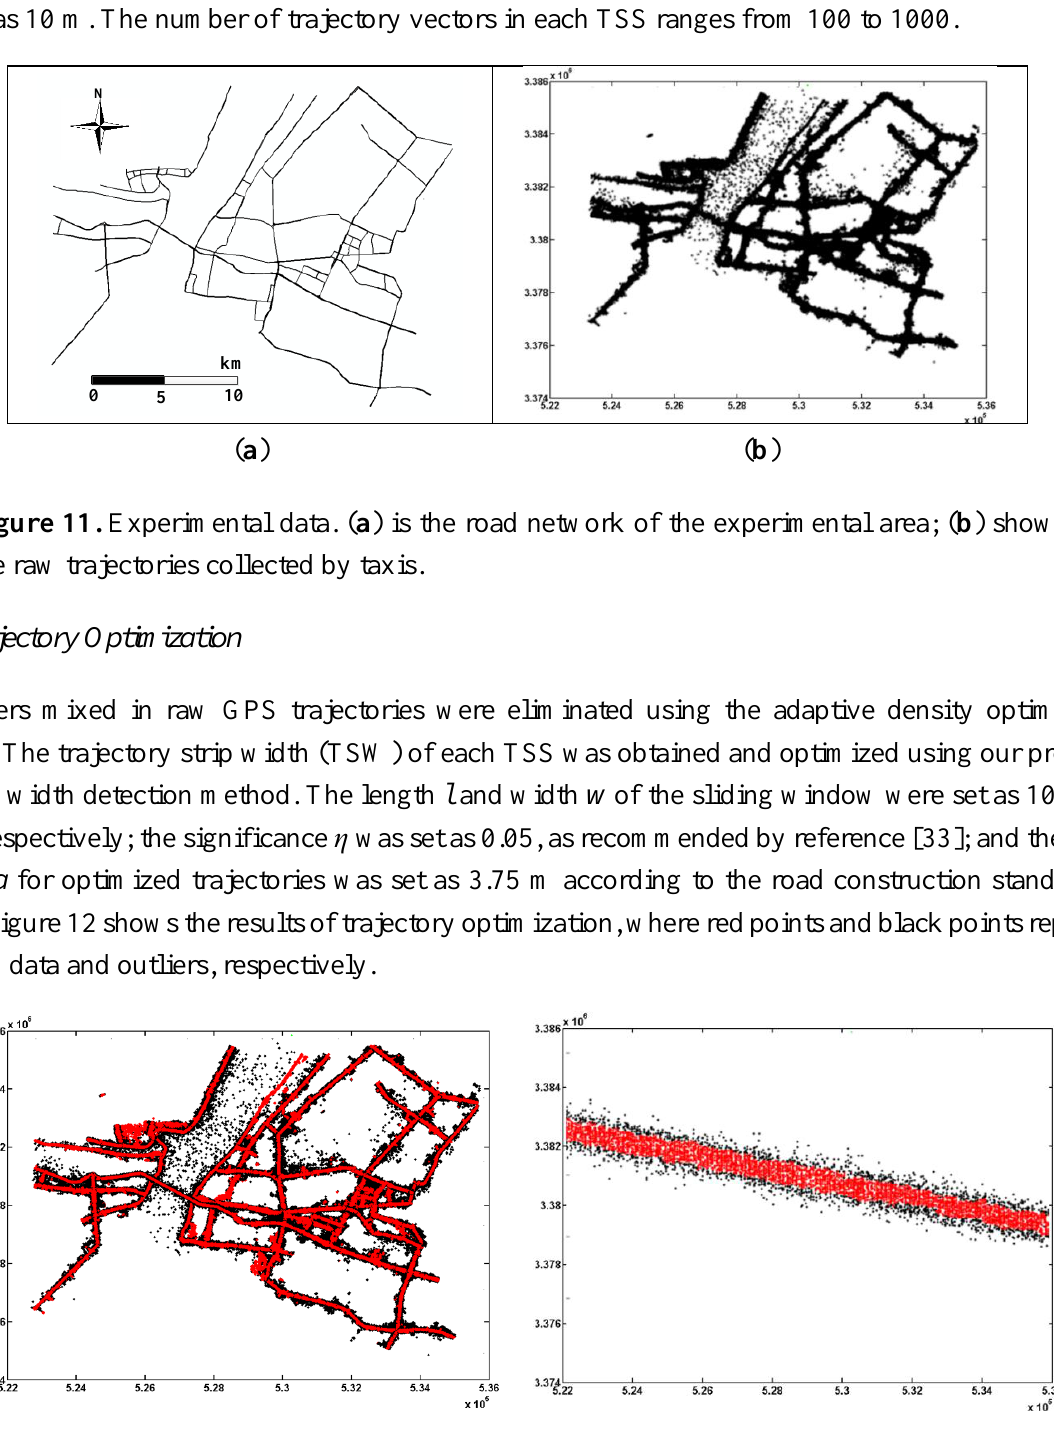
Figure 12. Optimization results. The result of all experimental data ( left ); the magnification of one segment ( right